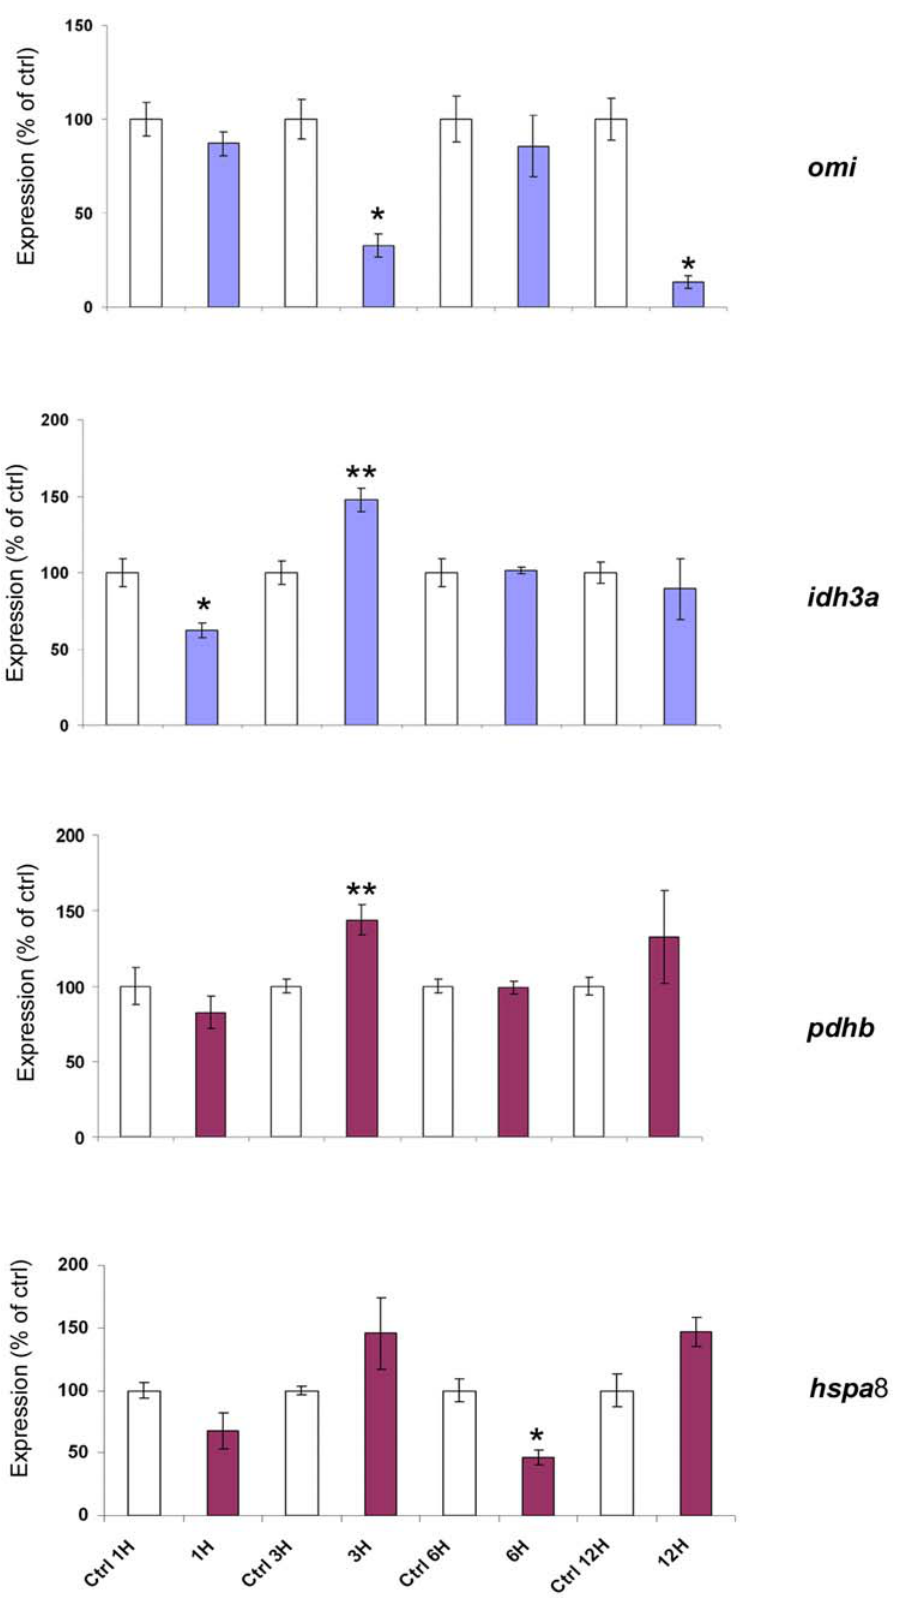
Figure 6. Gene expression studies of omi , idh3a,pdhb and hspa 8 in HEK293 cells treated with 10 nM Rotenone. Expression is normalized for b -actin and shown as a percentage of the untreated control (UnTx) where all data is the Mean 6 SEM: n $ 3, and where * indicates P # 0.005 and ** indicates P # 0.05 (using two tailed t-test analysis).